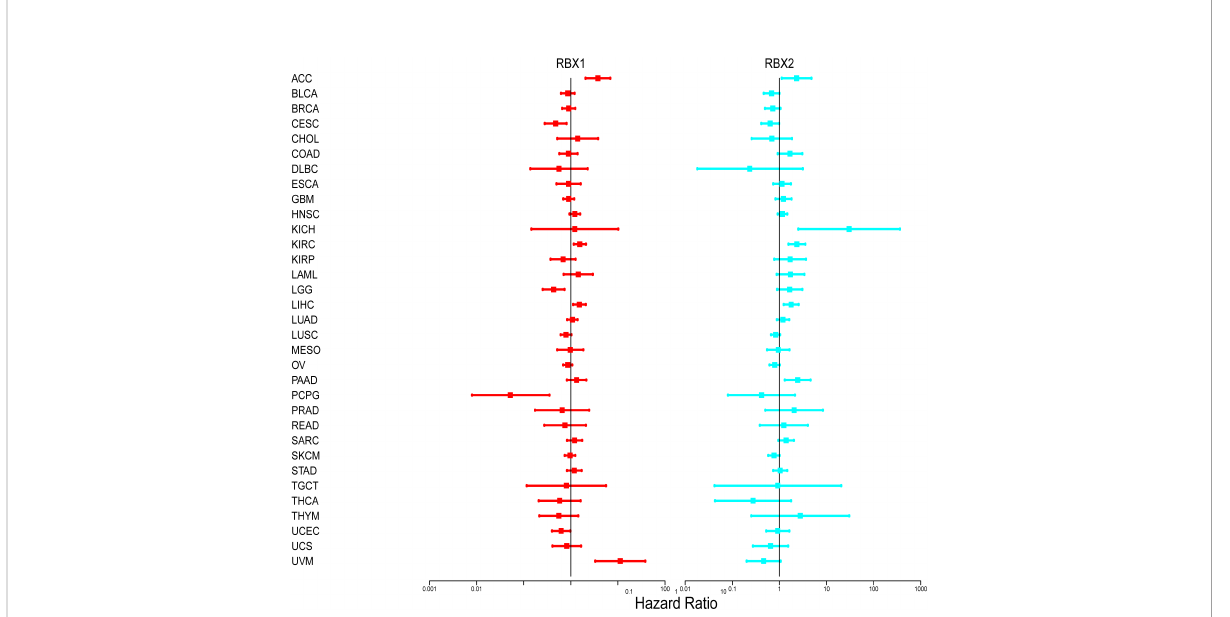
FIGURE 4 Association of RBX1/2 gene expression with patient ’ s overall survival for different cancer types. The forest plots with the hazard ratios and 95% con fi dence intervals for overall survival for different cancer types showing the survival advantage and disadvantage with the increased gene